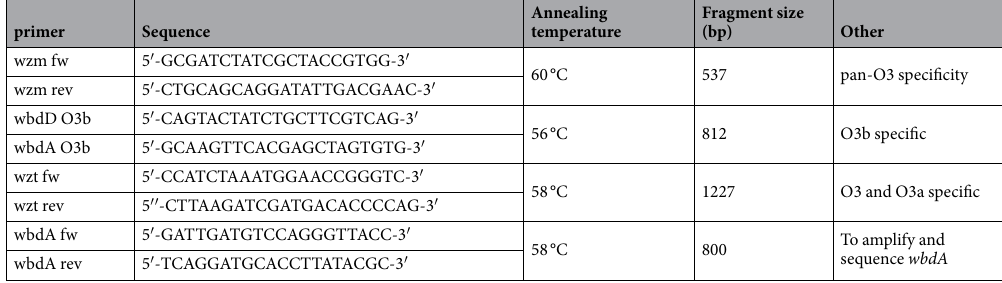
Table 3. Primers used in the